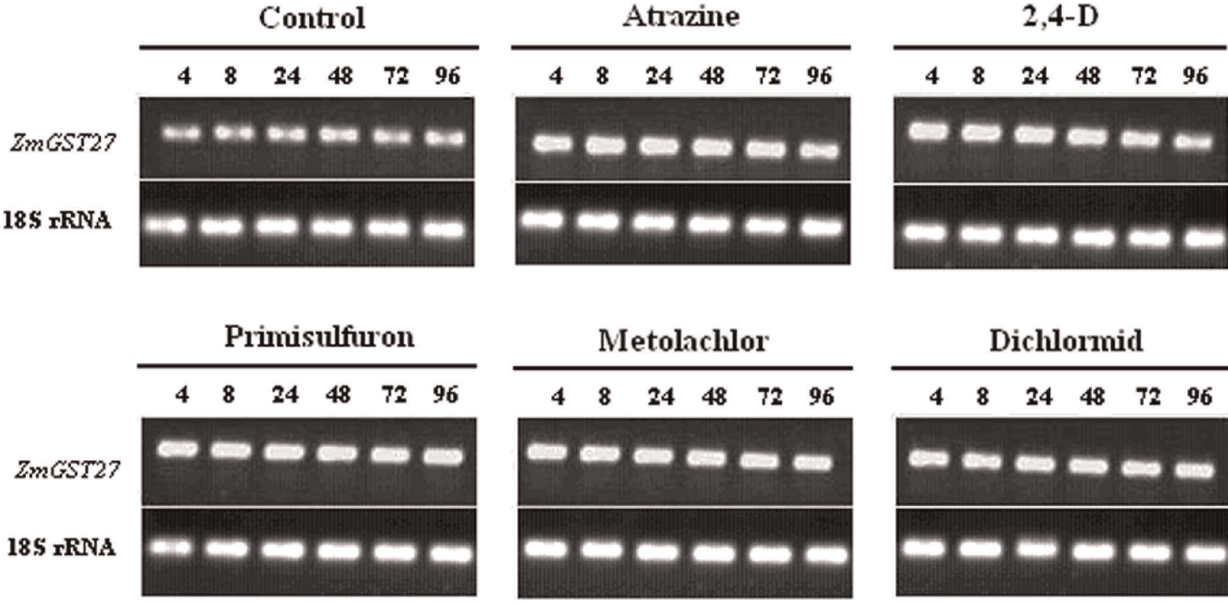
Figure 1. Semi-quantitative RT-PCR analysis of ZmGST27 expression in maize leaves after treatment by various chemicals. The numbers (4, 8, 24, 48, 72 and 96) above each lane indicate the time intervals (h) after treatment. The experiment was repeated twice with similar results.